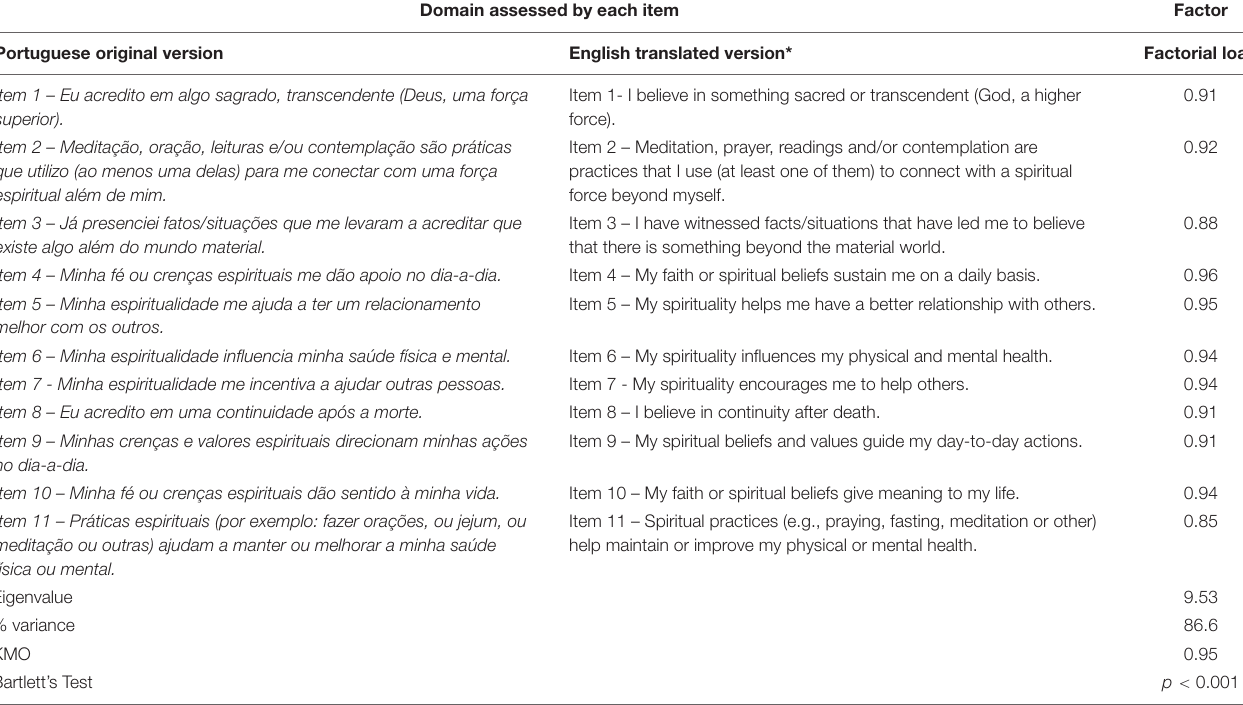
TABLE 2 | Exploratory factor analysis for the ARES ( n =